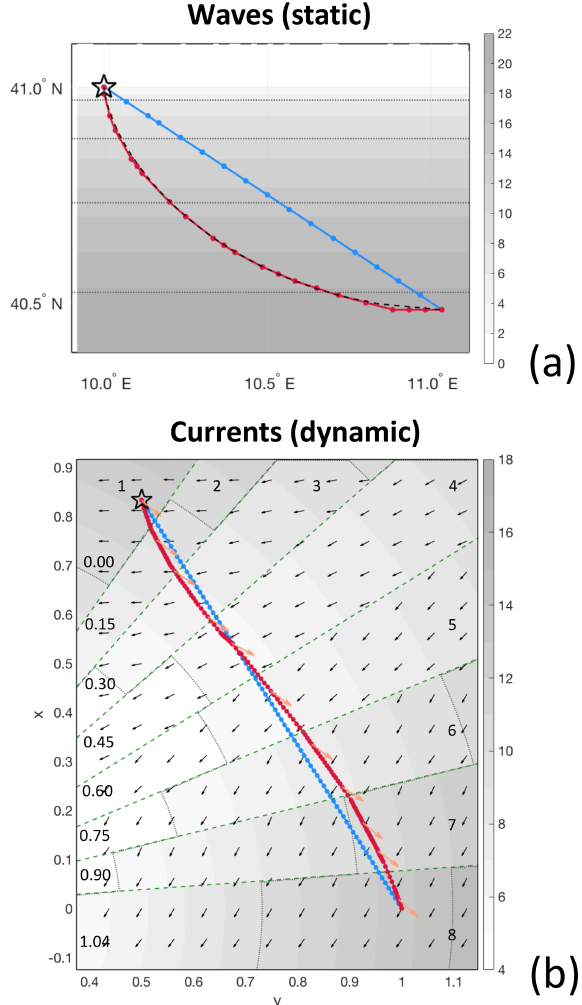
Figure 2. Verification of VISIR-1.b vs. benchmark solutions. Both least-distance (blue) and least-time (red) trajectories are displayed, and the tracks originate at the black star symbols. (a) A static ship velocity field as in Eq. (19) is shown; the analytical solution (branch of an inverted descent cycloid) is portrayed as a dashed black line (see Mannarini et al., 2016a, Fig. 9). (b) A time-dependent current field as in Eq. (20); the vehicle heading is portrayed as orange ar- rows. The radial sectors separated by green dashed lines refer to a sequence of time steps in the field, which are numbered in the outer sector. On the other hand, sector-mean times with a unit of T 0 are given in the inner sector. Sectors nos. 3, 6, and 8 should be com- pared to Techy (2011, Fig. 12a–c). In both (a) and (b) , the legend units are knots and velocity field isolines every 5kn are displayed as dots. Parameters of the synthetic fields are given in Table